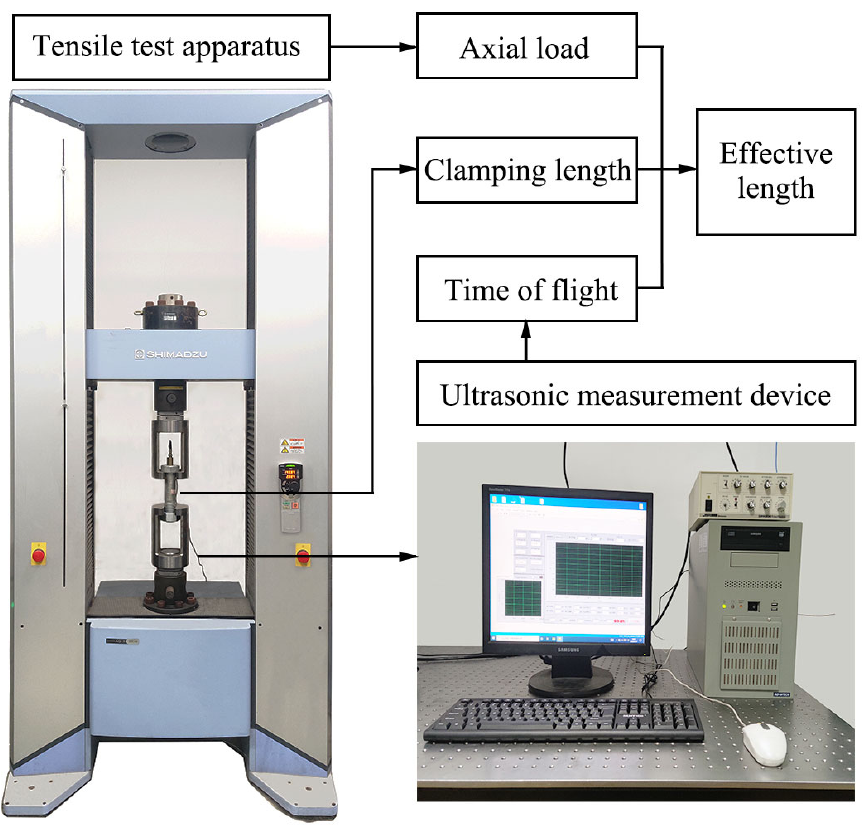
Figure 3. Bolt axial tension measurement experiment process.